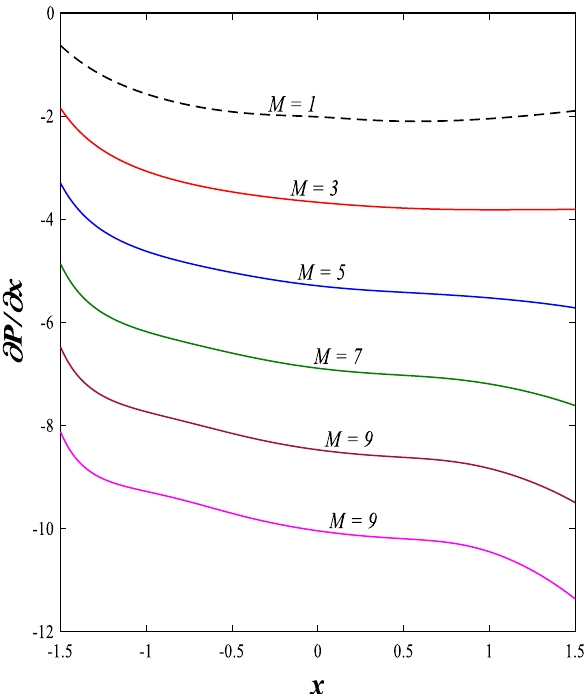
Figure 23. Effect of magnetic field parameter M on the pressure gradients distribution.